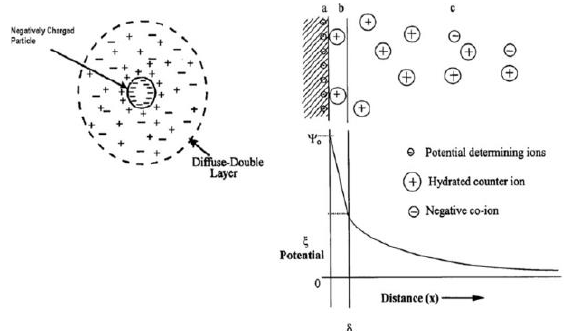
Figure 3. Schematic representation of the double layer and potential drop across the double layer: ( a ) surface charge; ( b ) Stern layer; ( c ) diffuse layers of counter-ions.